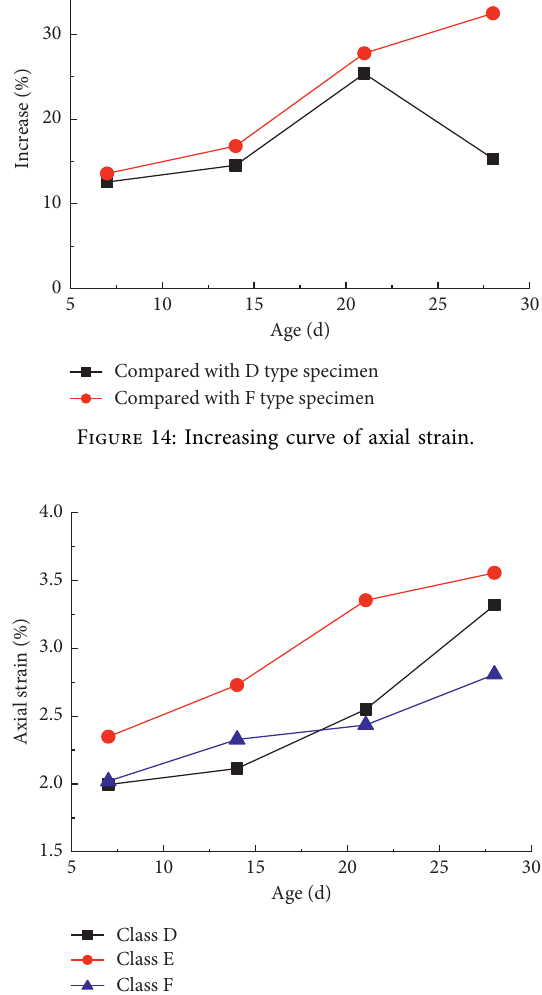
Figure 15: Elastic modulus curve of reinforcing cement paste.